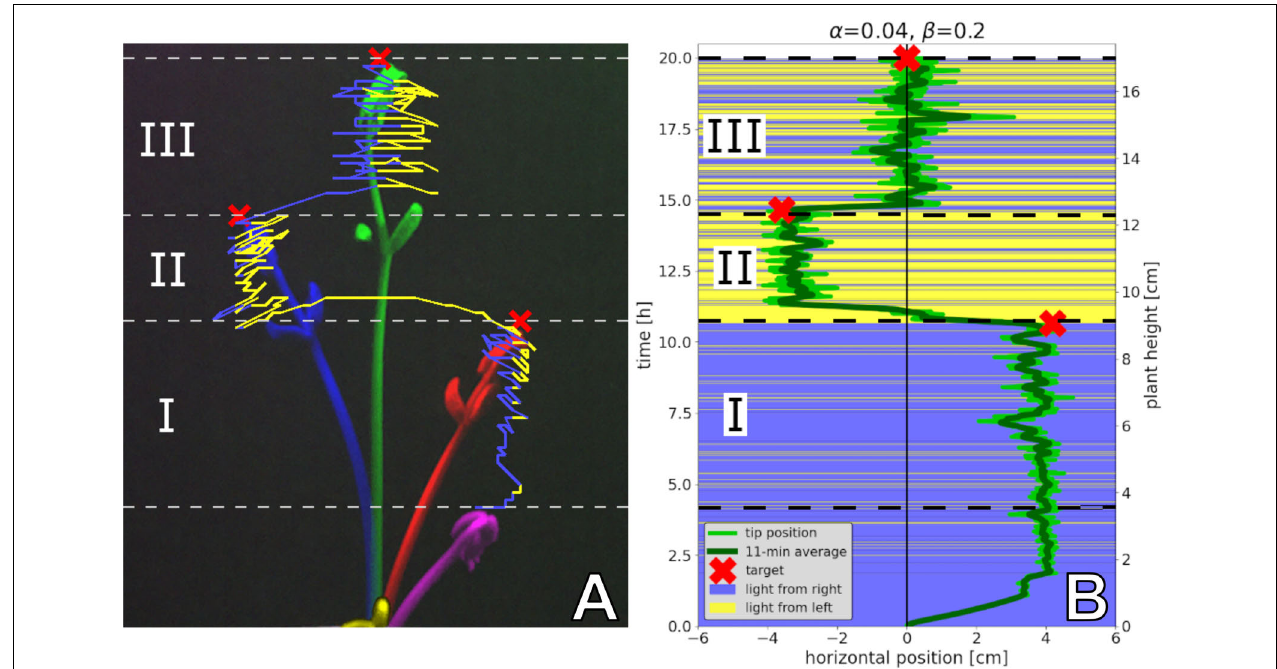
FIGURE 11 | Plant experiment and simulation of binary light control guiding a plant tip to hit three targets (shown with red crosses) during growth. (A) The image is compiled from five different time steps of an experiment reported in Hofstadler et al. (2017). For each time step shown, the bean is mapped to a different colour; the tip’s trajectory through the 2D projection plane of the images throughout the experiment is overlaid (in yellow when the light comes from the left, and blue otherwise). The emerging seedling is shown in yellow (bottom centre). In magenta, we see the bean when the plant tip was first detected. This marks the beginning of phase I, where light mainly comes from the right side in order to keep the bean below the first target (at a height of 9 and 4 cm to the right) until it is reached (red bean). In phase II, the bean is guided to the second target (height = 12 cm, 3.5 cm to the left) on the left. Note the fast reaction ( ∼ 15 min) indicated by the yellow curve of the trajectory from the first target towards the left side, when the light regime changes. Thereafter, phase II is again characterised by the typical oscillations (due to circumnutation) below the target until it is reached (blue bean). In phase III, the target is located centrally (height = 17 cm), leading to frequent light switching and larger horizontal movements of the tip. The bean drawn in green has reached this final target. (B) A simulation run of the plant model (with parameters according to Figure 2C ). The vertical axis represents time (at 1-min resolution), instead of the actual position projected onto the image plane. The targets have been placed according to the simplification of a linear conversion of time into height (ignoring geometrical constraints and assuming a constant growth rate). This implies that no downward motion of the tip is to be expected, since time progresses linearly in our model. Our model aims to describe a plant tip’s behaviour from germination onwards, while in the experiments with real plants, tip detection only kicked in at a height of ∼ 3.5 cm. There is thus no basis for a comparison for these early time steps. Furthermore, the model’s parameters are not tuned to accurately represent this very early phase of growth. During phases I–III, behaviours very similar (qualitatively) to those of the real plants can be observed. Keeping the tip below targets far from the central axis requires light from the according direction most of the time. The final and central target allows for larger horizontal motion and requires frequent shifts in light direction to keep the tip in position, as observed in the real plants in (A)